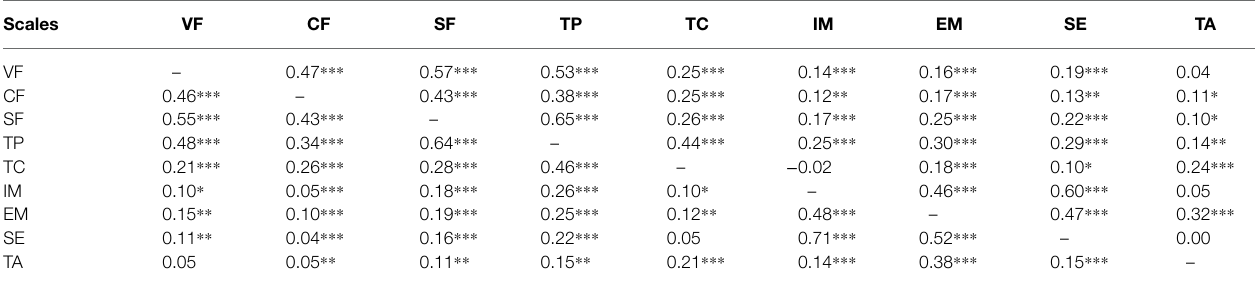
TABLE 4 | Zero-order correlations among all variables of students’ perceptions of teacher feedback and male and female students’ motivation. Scales VF CF SF